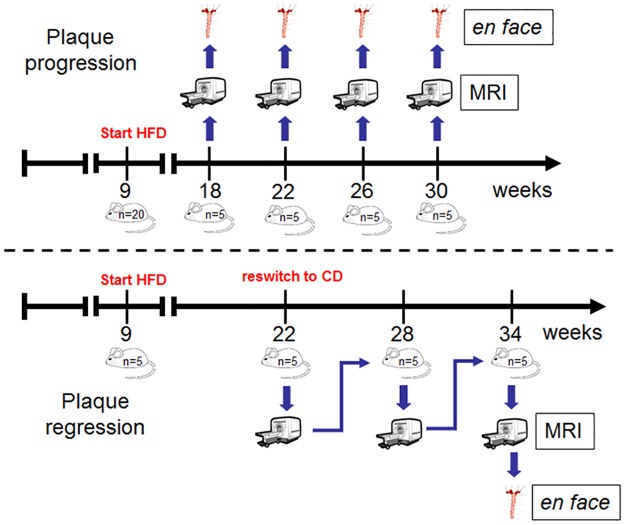
Study design.For atherosclerotic plaque progression analysis ApoE-/- mice (n = 20; progression group) were set on high fat diet (HFD) at 9 weeks of age. Mice were than grouped (n = 5 for each time point) and MRI performed after 9, 13, 17 and 21 weeks on HFD. En face preparation was performed immediately after MRI. For atherosclerotic plaque regression analysis ApoE-/- mice (n = 5, regressiony group) were also set on HFD at 9 weeks of age. First MRI examination was performed 13 weeks after starting the HFD. At this time point diet was switched back to chow diet (CD) and MRI analysis was repeated at the age of 28 and 34 weeks before en face preparation was done.